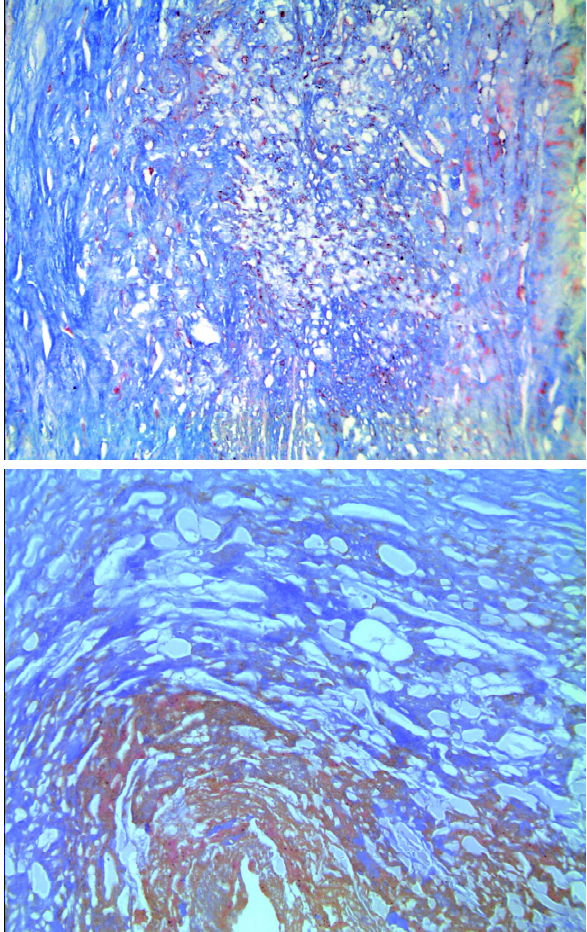
Fig. 3 – Cystic medial necrosis of ascending aortic aneurysm of (A) a 47-year-old male patient diagnosed of ascending aiortic aneurysm, showing much collagen deposition in the intima and smooth muscle cell fragmentation with few collagen and cystic-like lesions in the media, and (B) another 47-year-old male patient diagnosed of ascending aortic aneurysm with aortic insufficiency and stenosis, showing degenerative disruptions elastic fibers and smooth muscle cells with few collagen but more cystic-like lesions in the media.